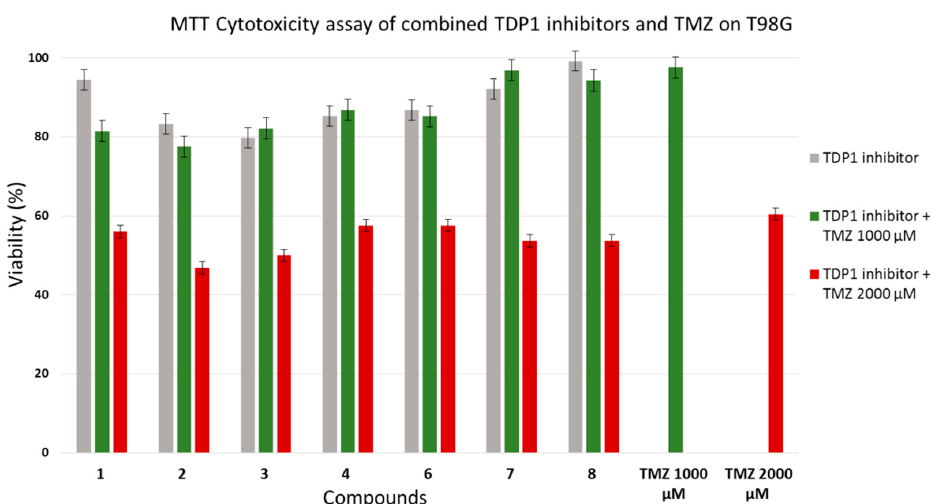
Figure 5. Cytotoxicities of combinations of studied compounds with temozolomide in T98G glioma cell line.